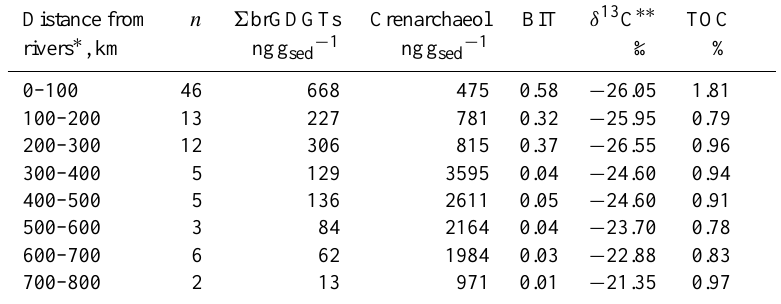
Table 2. Summed brGDGTs, crenarchaeol concentrations, BIT, δ 13 C and TOC values on the East Siberian Arctic Shelf, grouped by distance from river mouths. Distance from n (cid:54) brGDGTs Crenarchaeol BIT δ 13 C ∗∗ TOC rivers ∗ , km ngg sed − 1 ngg sed − 1 ‰ % 0–100 46 668 475 0.58 227